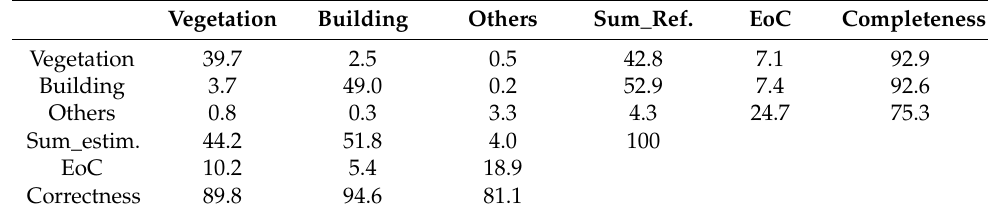
The overall accuracy of the classifier is 92%, with an overall miss ‐ classification rate Table 5. Confusion matrix for the training data set after applying the 30 attributes classification model.